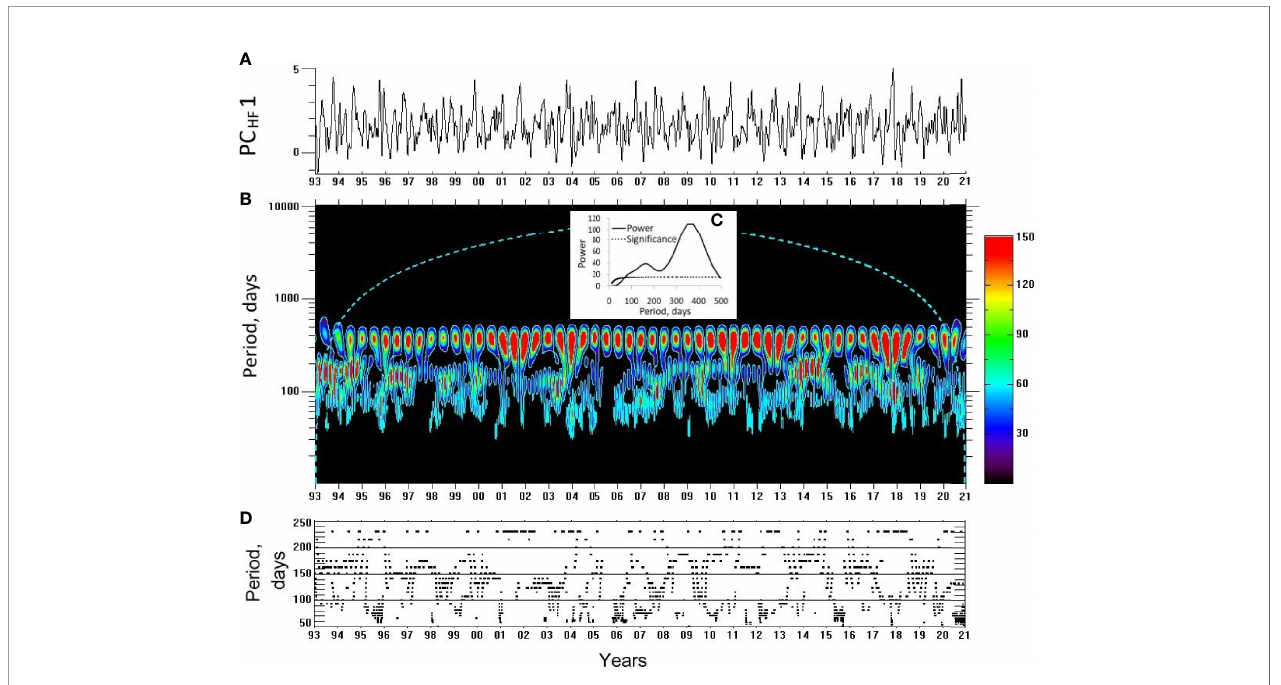
FIGURE 2 | (A) The principal component PC HF 1 (dimensionless) for the northern JES, (B) its WT spectrum, (C) its time-averaged WT spectrum, and (D) the periods (days) of maximum power in the range between 50 and 250 days. In (B) and hereafter the 90% con fi dence levels are shown by solid cyan contours and COIs by dashed cyan